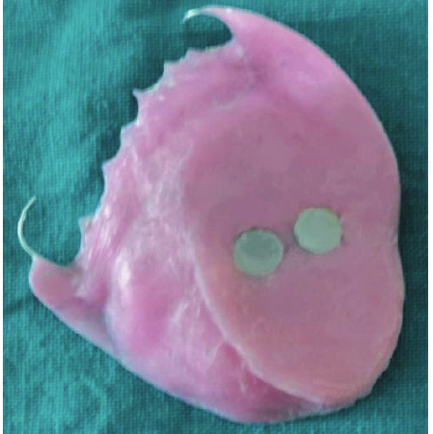
Figure 15: Tissue surface with magnets.